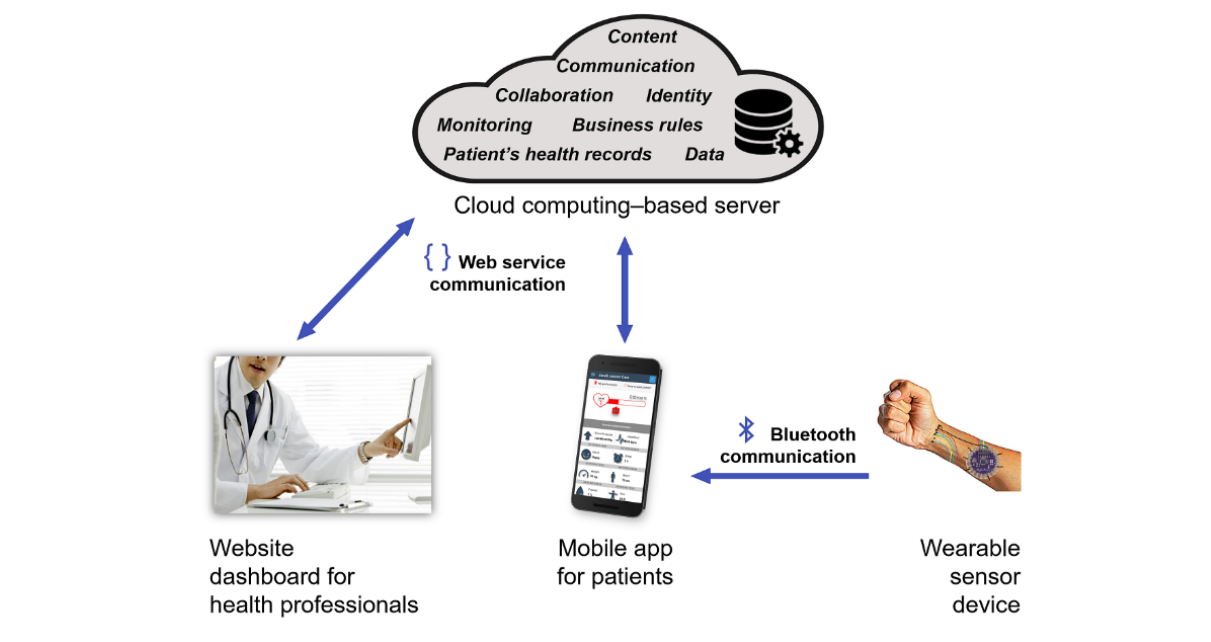
Figure 1. Computing architecture of the electronic health